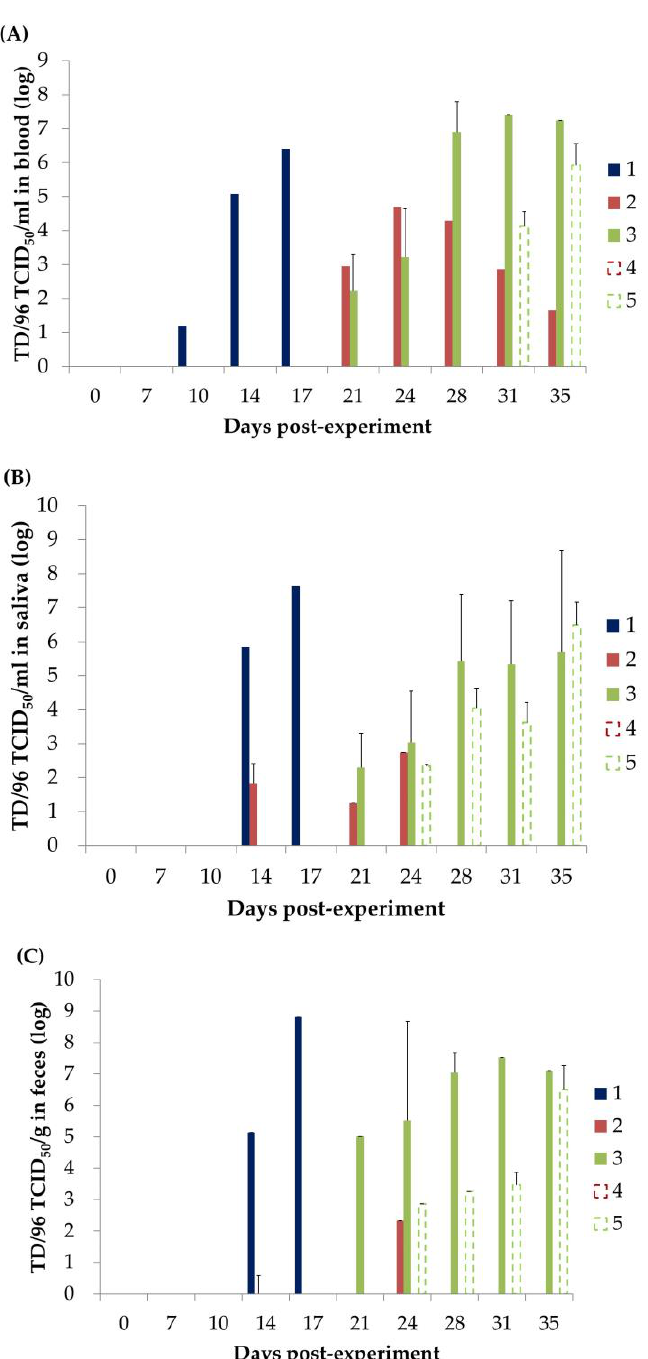
Figure 3. CSFV loads present in the ( A ) blood, ( B ) saliva, and ( C ) feces of the piglets in each group. In Groups 2 and 3, the presence of MDAs delayed the first detection of viremia until 10 DP1C (i.e., the piglets remained asymptomatic until 17 DPE; Table 1) with the primary